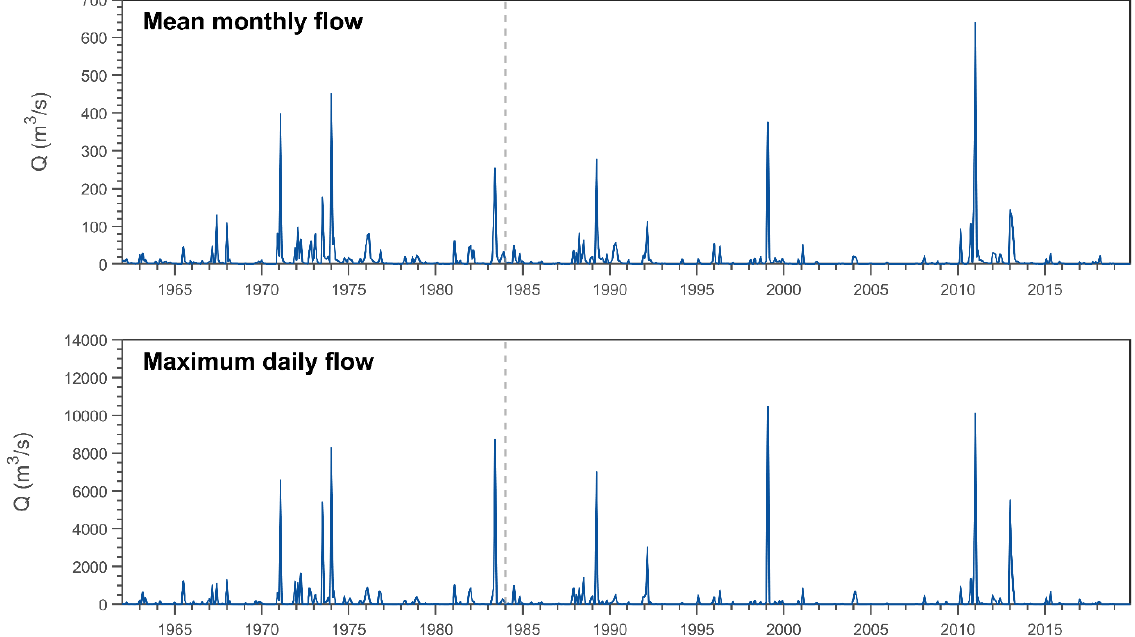
Figure A1. Mean monthly (top) and maximum daily (top) observed inflow hydrographs of the Brisbane River at Gregors Creek. The dashed line indicates the construction of the Wivenhoe Dam.